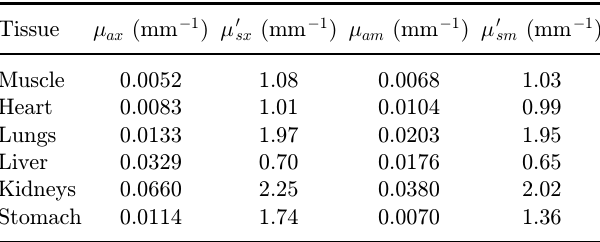
Table 1. Optical parameters of the mouse organs. Tissue